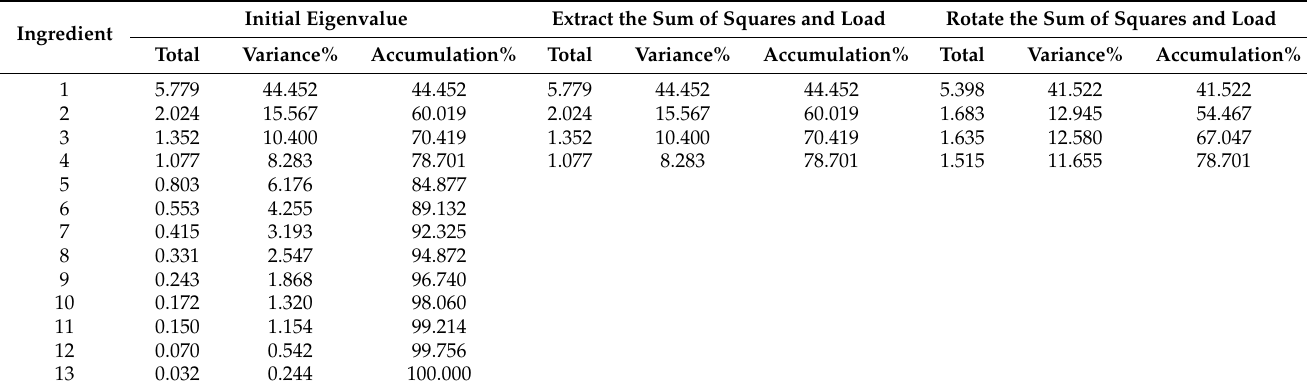
Table 3. Comprehensive evaluation of city squares from the perspective of human settlements.